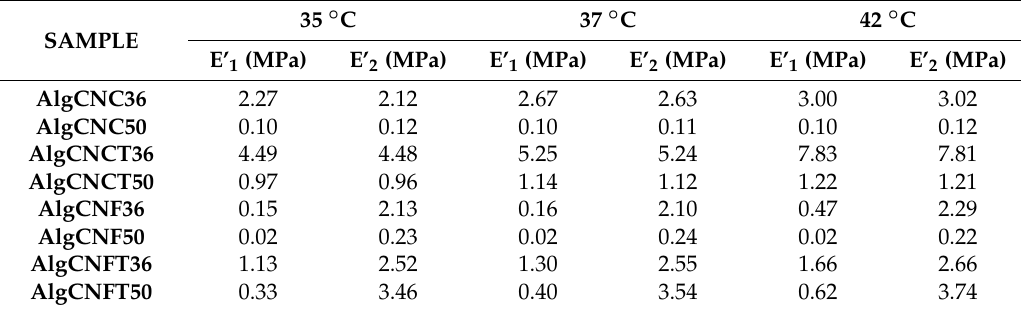
Table 3. Storage modulus after first (E’ 1 ) and second (E’ 2 ) heating/cooling cycles of the gels at 35